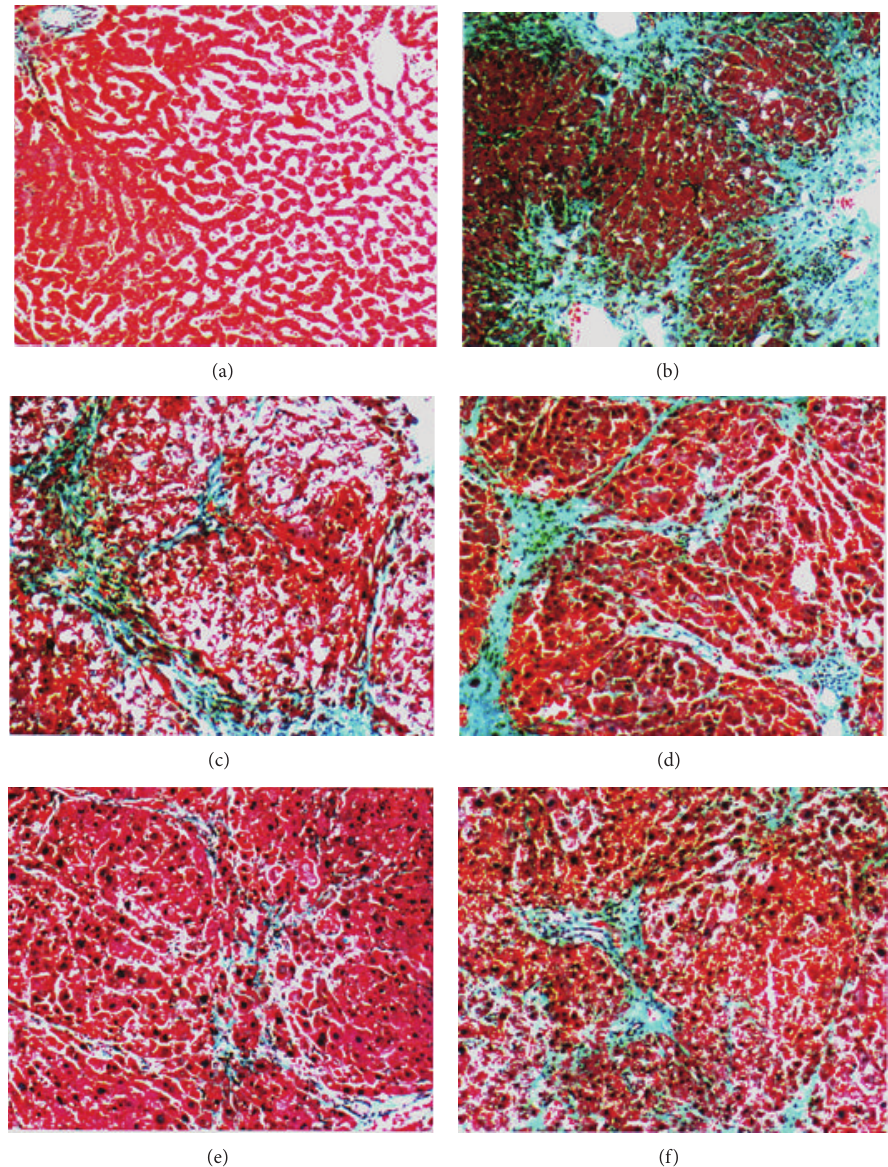
Figure 1: Histological examination performed by conducting Masson trichrome staining, 100x of JWXYS-treated and untreated rat liver. (a) vehicle, normal saline; control, normal liver; (b) DMN alone with marked widening, inflammation, and fibrotic portal tracts with bridging fibrosis. Nodular transformation was apparent. (c) DMN + 200 mg/kg of silymarin with moderate widening and fibrotic portal tracts with occasional bridging fibrosis; (d) DMN + 100 mg/kg of JWXYS with moderate widening and fibrotic portal tracts with bridging fibrosis and mild inflammatory cell infiltration; (e) DMN + 300 mg/kg of JWXYS with focal mild fibrotic change of the portal tracts and bridging fibrosis; (f) DMN + 1000mg/kg of JWXYS with mild to moderate fibrotic portal tracts with bridging